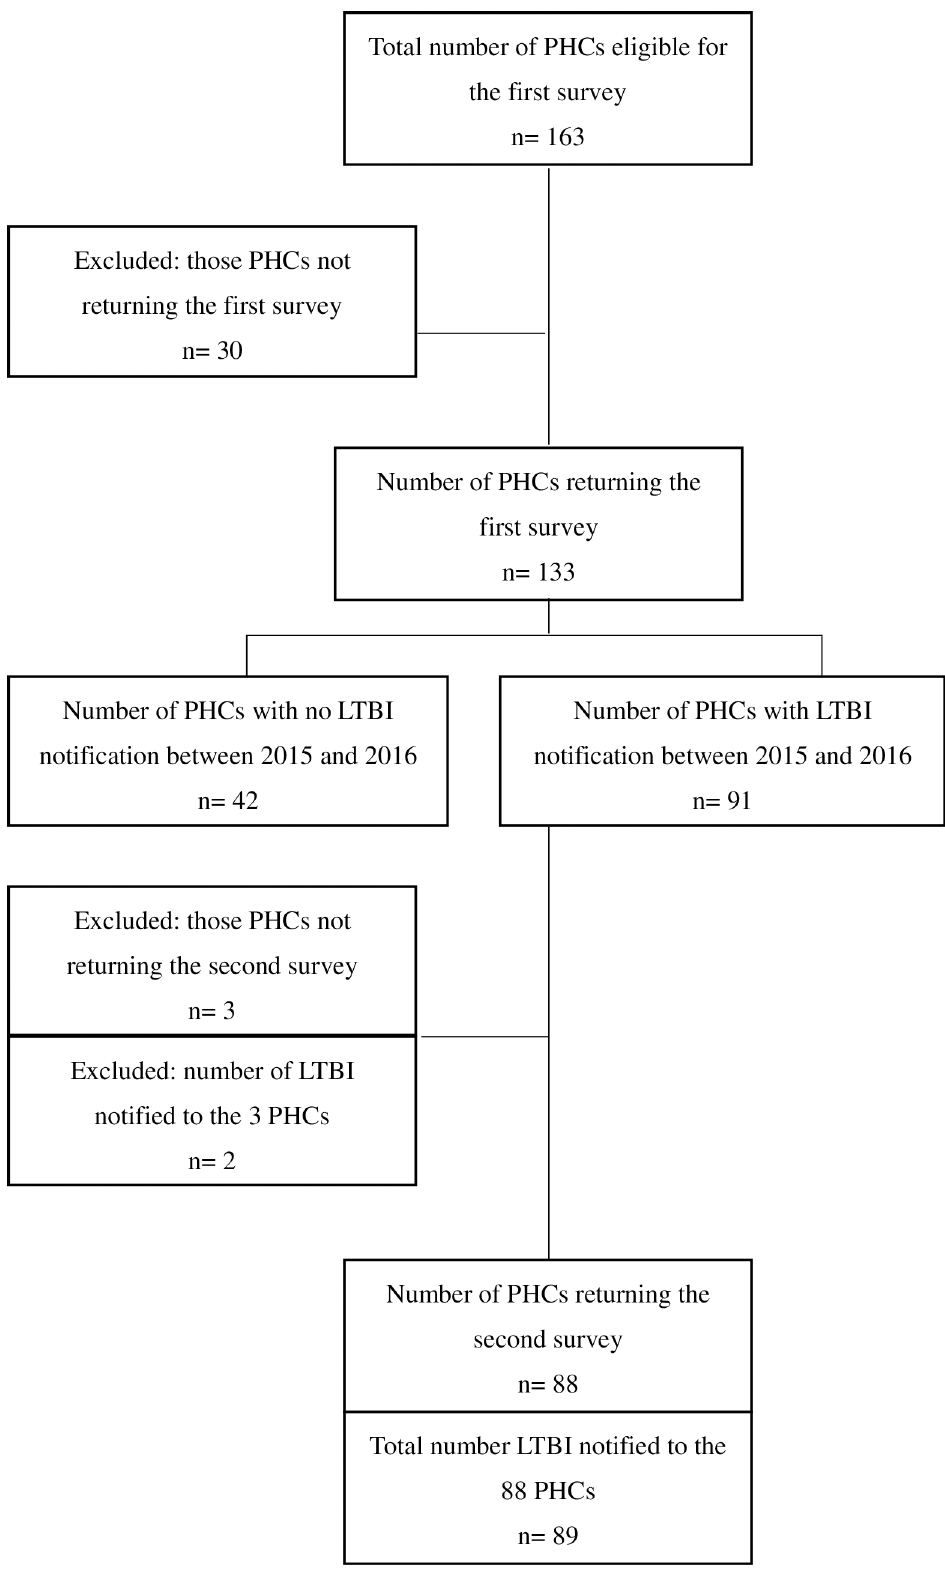
Fig 1. Flow chart of study population. PHC: public health center, LTBI latent tuberculosis infection.